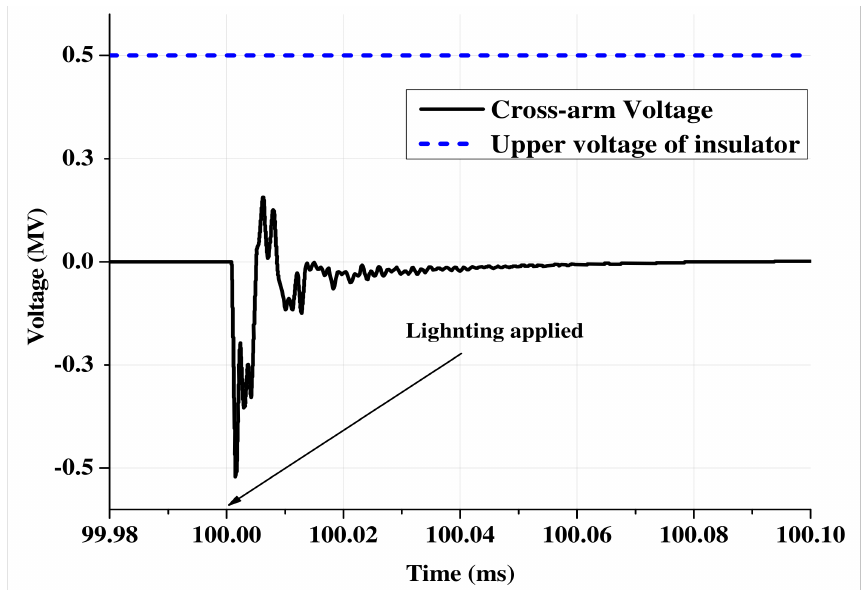
Figure 11. Voltage at tower cross-arm point and upper point of insulator with 10 kA lightning current.